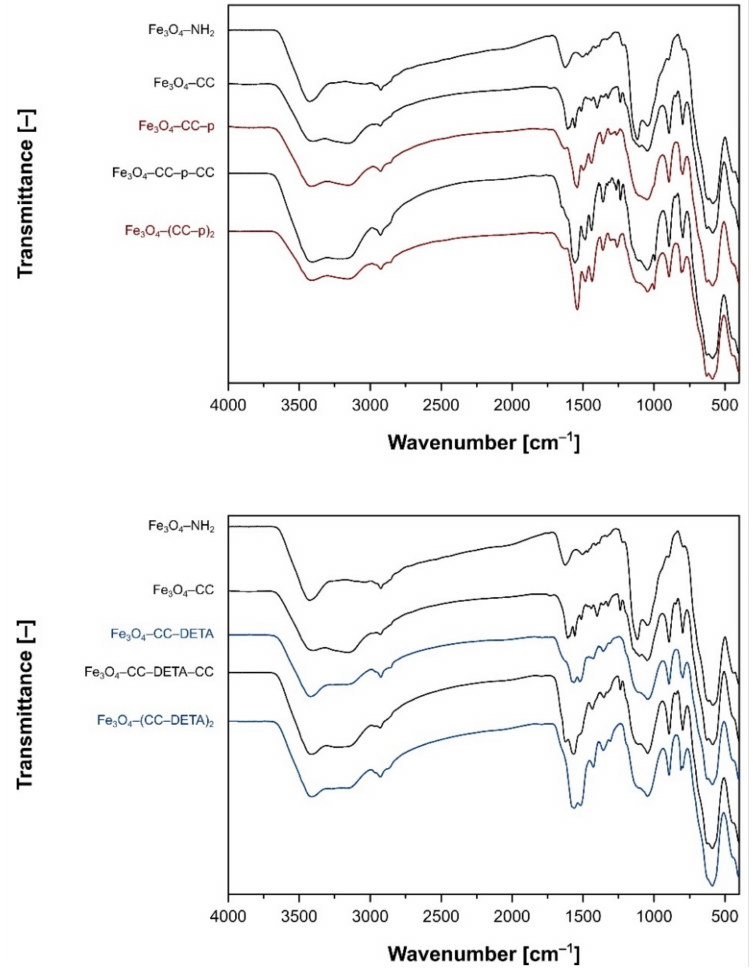
Figure 3. The FT–IR spectra of the magnetic support (Fe 3 O 4 –NH 2 ), the cyanuric chloride (CC) intermediates (Fe 3 O 4 –CC and Fe 3 O 4 –CC–amine–CC), and the dendron-functionalized materials (Fe 3 O 4 –CC–amine and Fe 3 O 4 –(CC–amine) 2 ) containing piperazine (p) (top) and diethylenetriamine (DETA) (bottom) as an amine